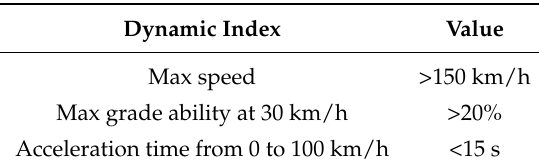
Table 8. Dynamic index of E-REV.